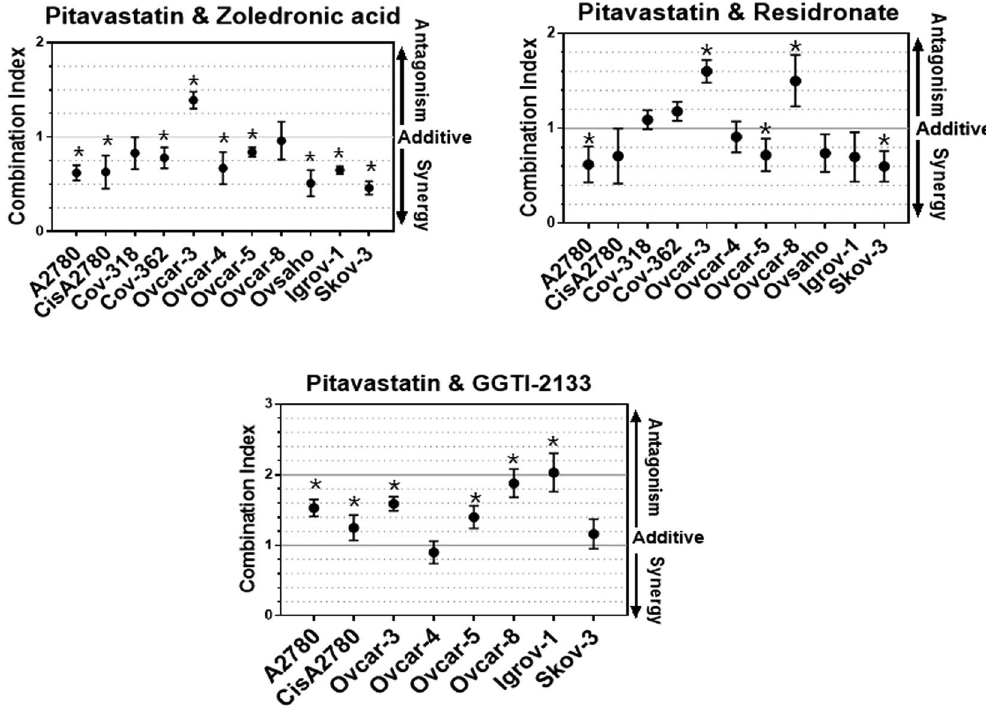
Figure 1. The effect of pitavastatin combinations in cell growth assays. To measure the activity of pitavastatin in combination with other agents, the indicated cells were simultaneously exposed to a range of pitavastatin concentrations with fixed concentration of zoledronic acid (10 µ M), or risedronate (10 µ M) or GGTI-2133 (5 µ M). Combination indices (CI) (mean ± S.D., n = 3–4) are quoted at a fraction affected of 0.5 and differed significantly from unity where indicated ( * Paired t-test, P ≤